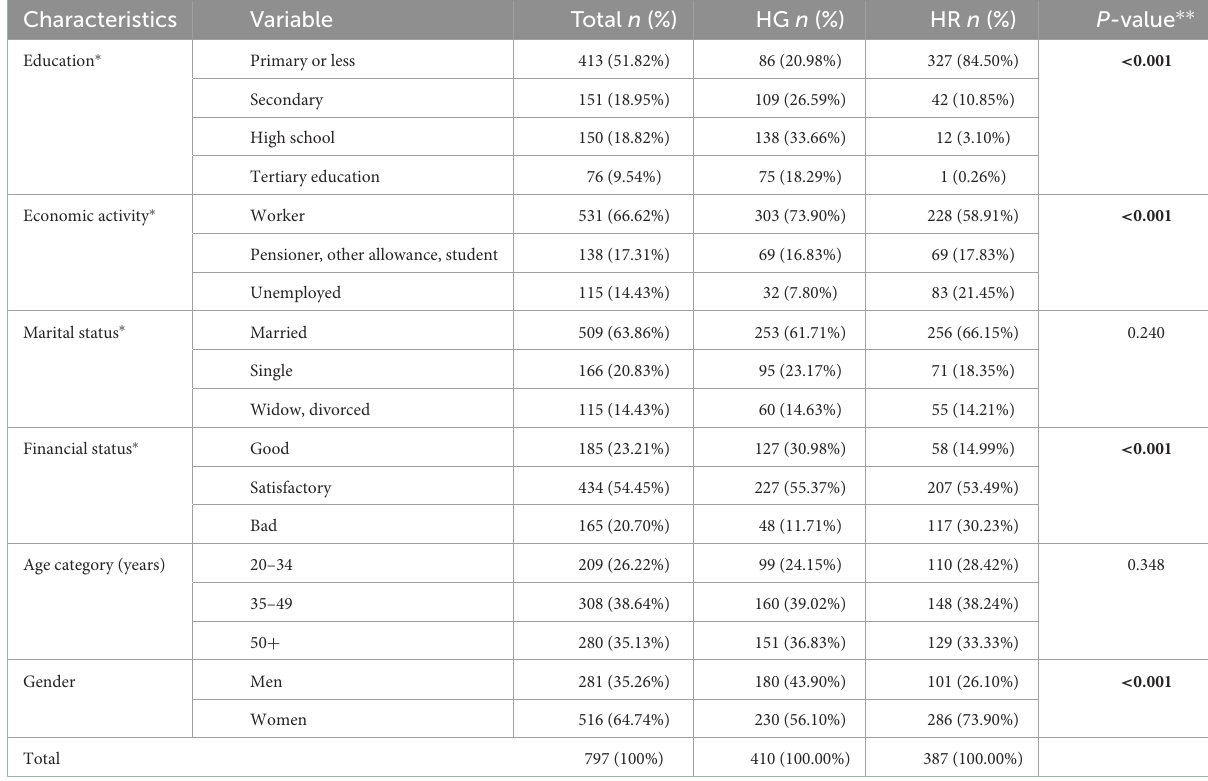
TABLE 1 Characteristics of the Hungarian general and Roma populations.